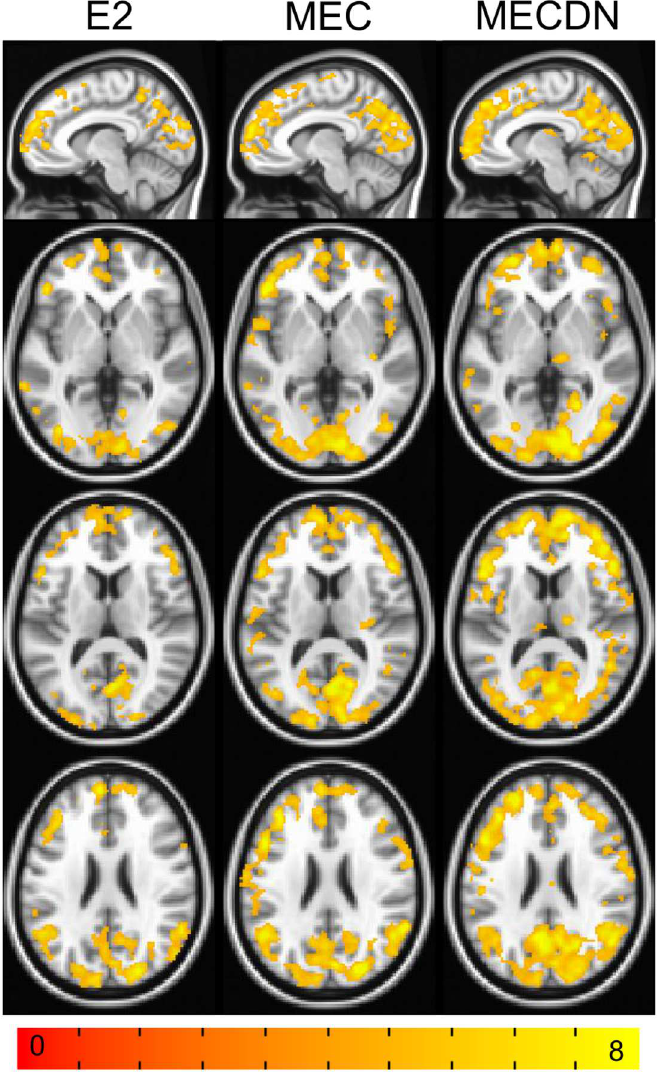
Fig 8. Group CBF/BOLD coupling. Results are shown for the E2, MEC and MECDN datasets. Widespread couplingwas observed and increasedcouplingwas seen within well-knownbrain networks including the DMN, and visual networks. Stronger, more widespread couplingwas seen for the MECDN data comparedto the MEC and E2